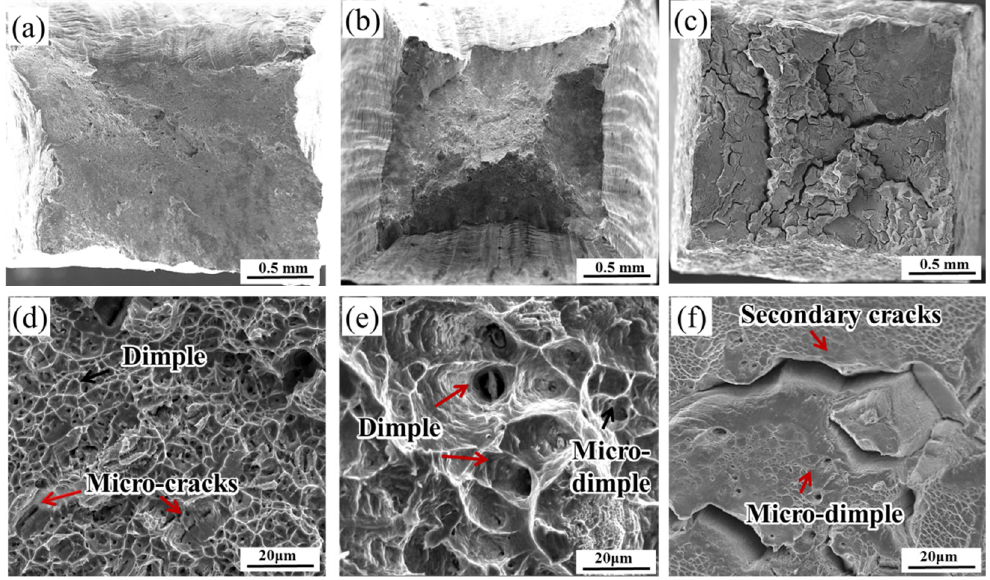
Figure 13. SEM morphology of the as-welded ( a , d ), furnace-heated (FH) ( b , e ), and thermally shocked (TS) ( c , f )